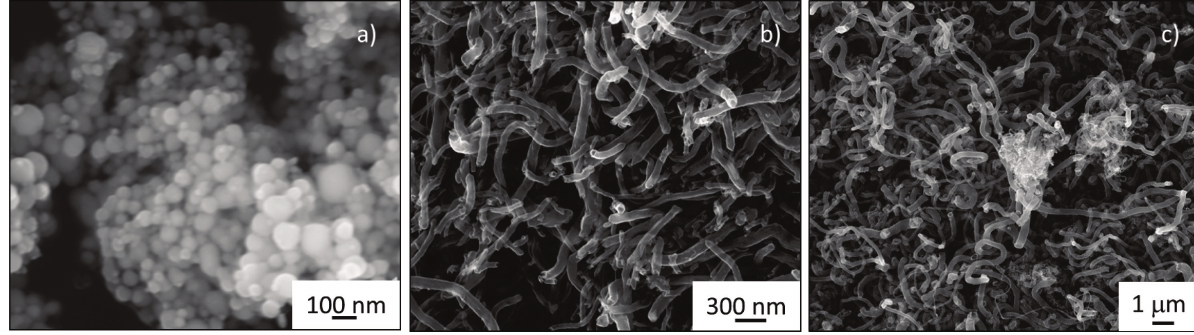
precursors and CNF/IF-WS hybrid . 2 2 2